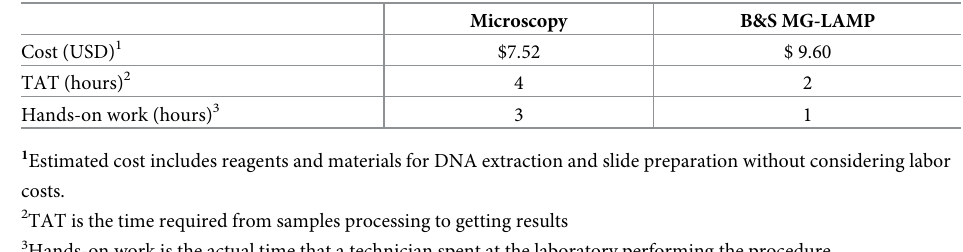
Table 3. Cost and TAT of B&S MG-LAMP assay and expert microscopy for 8 samples (One strip of